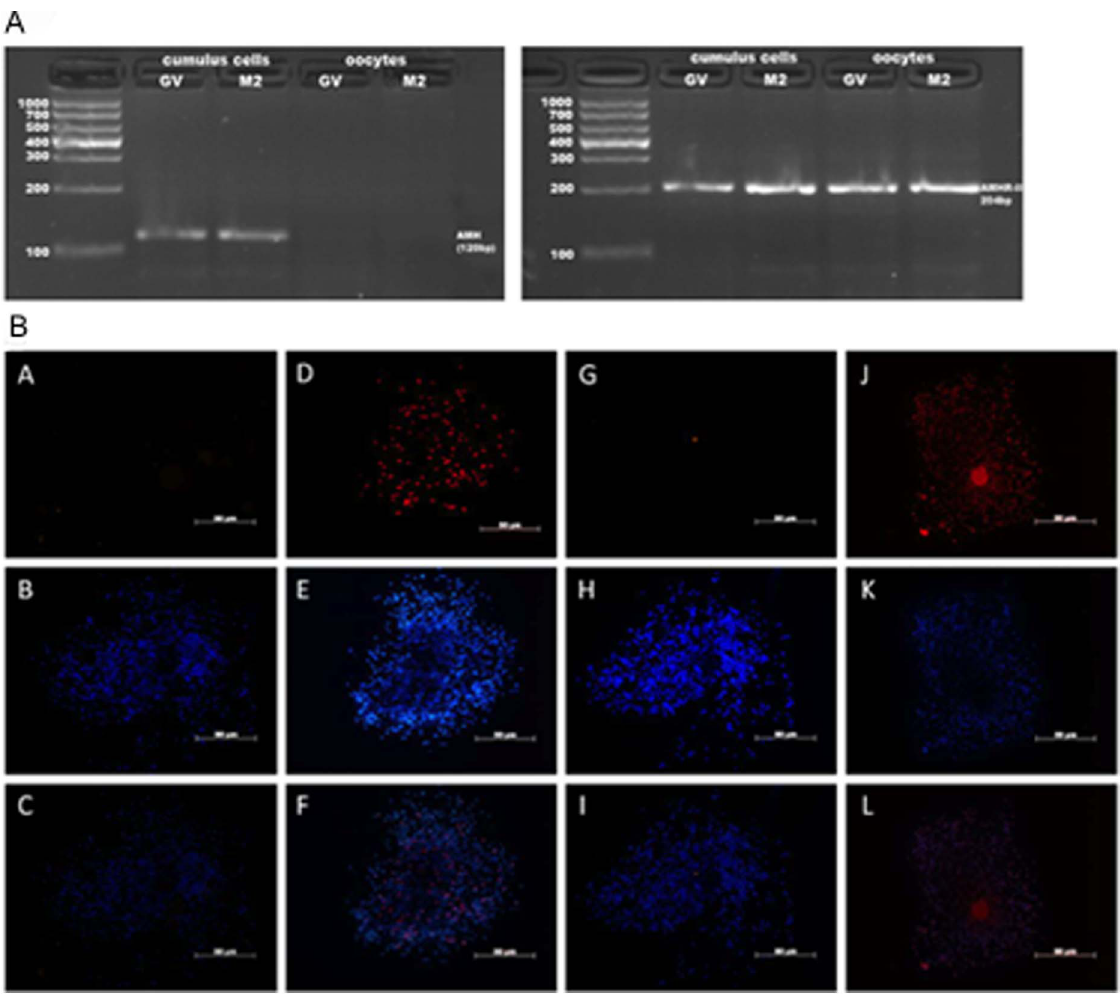
Figure 1. Localization of AMH and AMHR-II by PCR and immunofluorescence staining. ( A ) RNA was isolated from oocytes and cumulus cells from 30 COCs that were at GV stage or at MII stage after IVM, respectively. One-microliter amounts of cDNA were used as templates for PCR. ( B ) COCs after 16–18 h of culture in vitro were stained with mouse isotype IgGs as negative controls of AMH (A) and AMHR-II (G), AMH (D), AMHR-II (J) respectively, followed by TRITC conjugated secondary antibodies and DAPI (B,E,H,K), and merged images (C,F,I,L). Bars=50 m m.